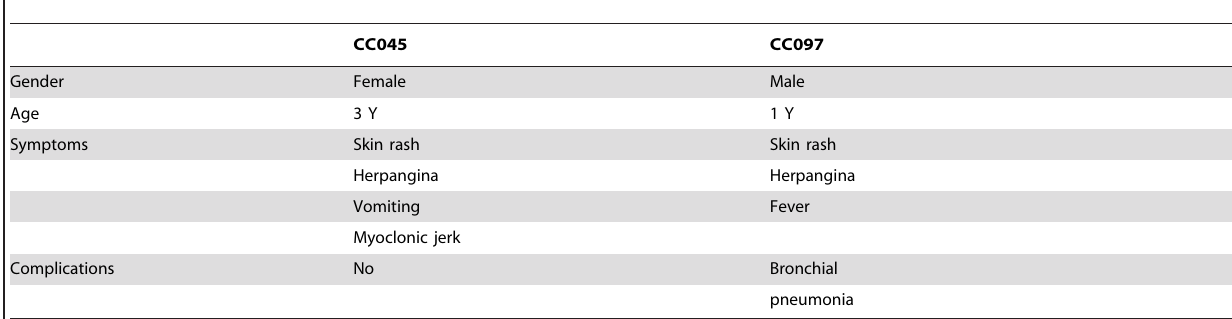
Table 1. Clinical features of CC045 and CC097